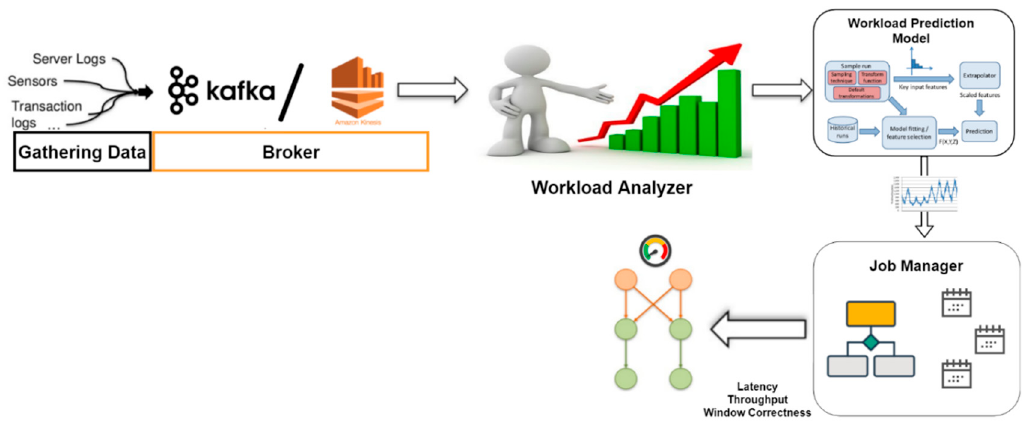
Figure 9. Proposed system architecture: Event gathering systems collect the data, pipelining it to the data broker for validation, then passing it onto the workload analyzer, which finally passes the obtained results onto the Job Manager through workload prediction module (adapted from